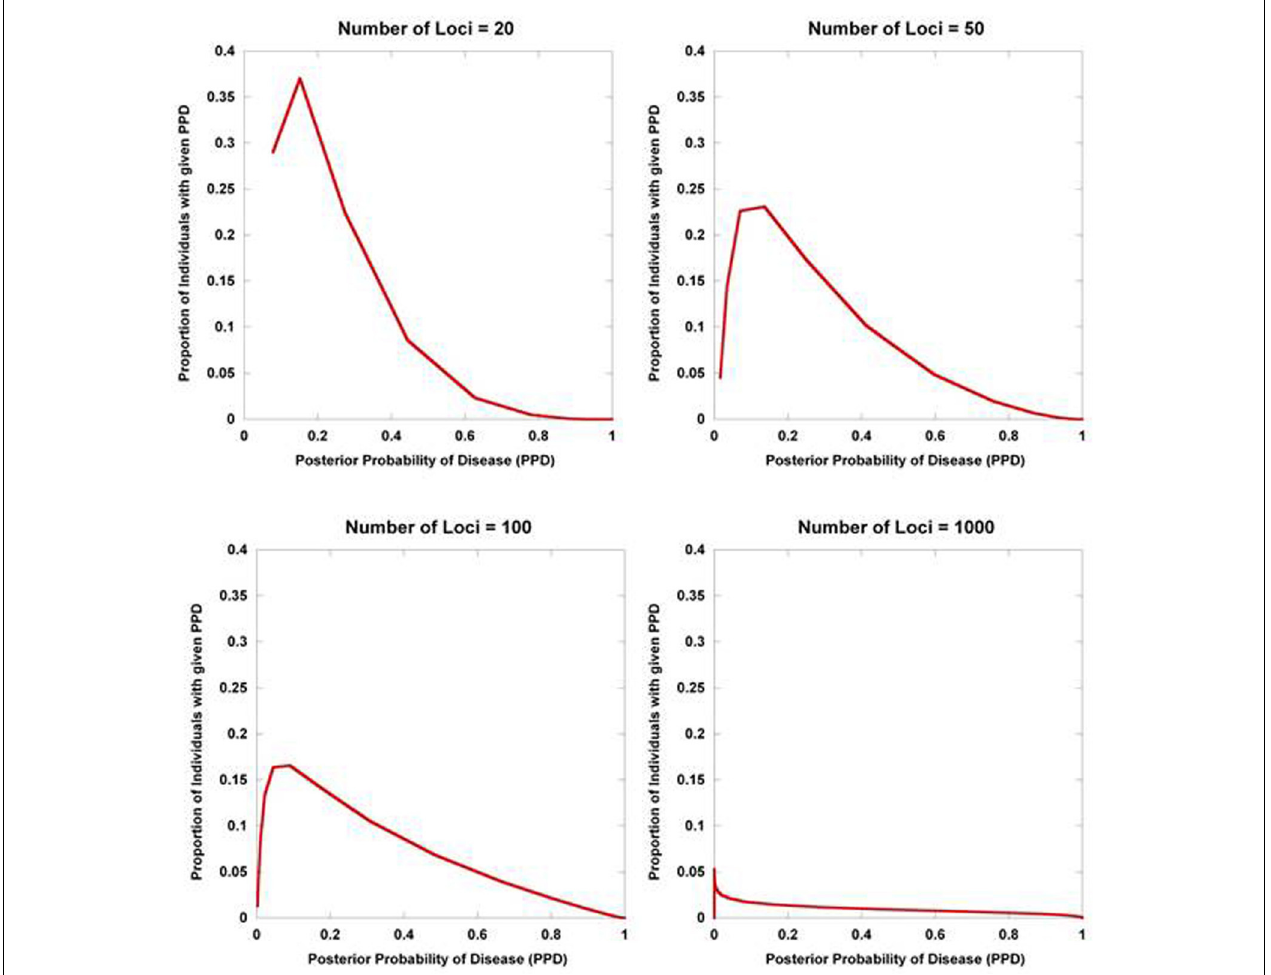
FIGURE 3 | Posterior probability variation with number of predisposing loci. The density of posterior probabilities of disease (PPD) is shown under a simplified multilocus disease model. The relative risk of each independent, disease-predisposing SNP was set to 2.0. Prior probability of disease was set at 0.20. Frequency of the predisposing genotype in controls was set to 0.05